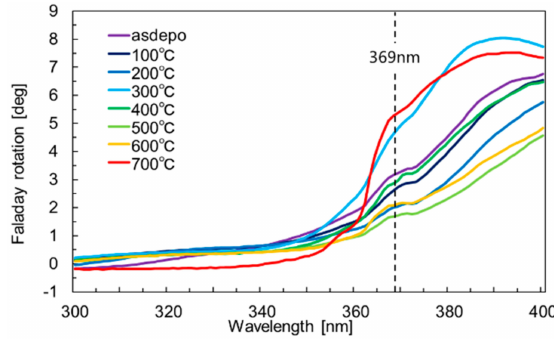
Figure 10. Faraday rotation spectra of Al:ZnO/Bi:YIG bilayer at various annealing temperatures.